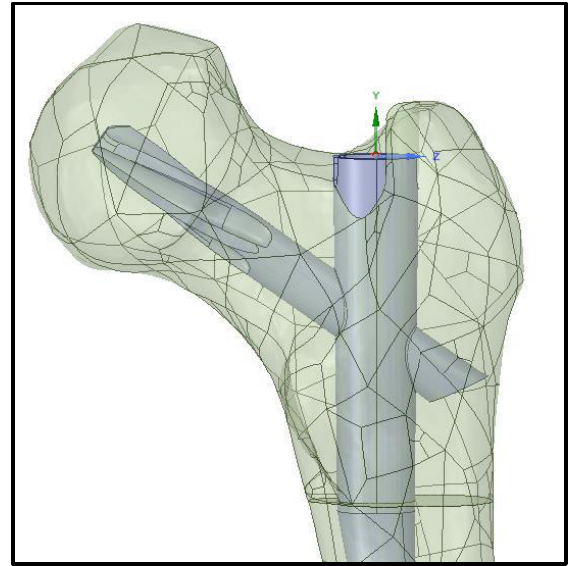
Figure 5. Femoral nail positioned within the femur model. Table 1. Number of nodes and elements per femur model. Femoral